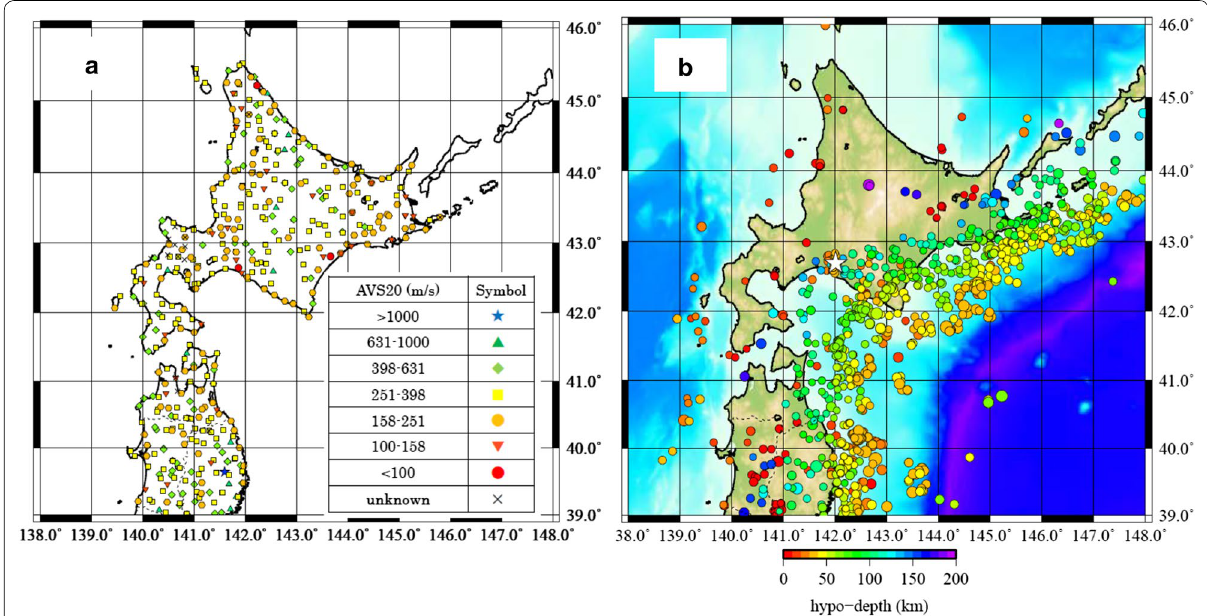
Fig. 1 Distributions of a stations and b earthquakes used in this study. Colored symbols indicate average S-wave velocity from the ground surface to a depth of 20 m (AVS20). b White star indicates the epicenter of the 2018 Hokkaido Eastern Iburi